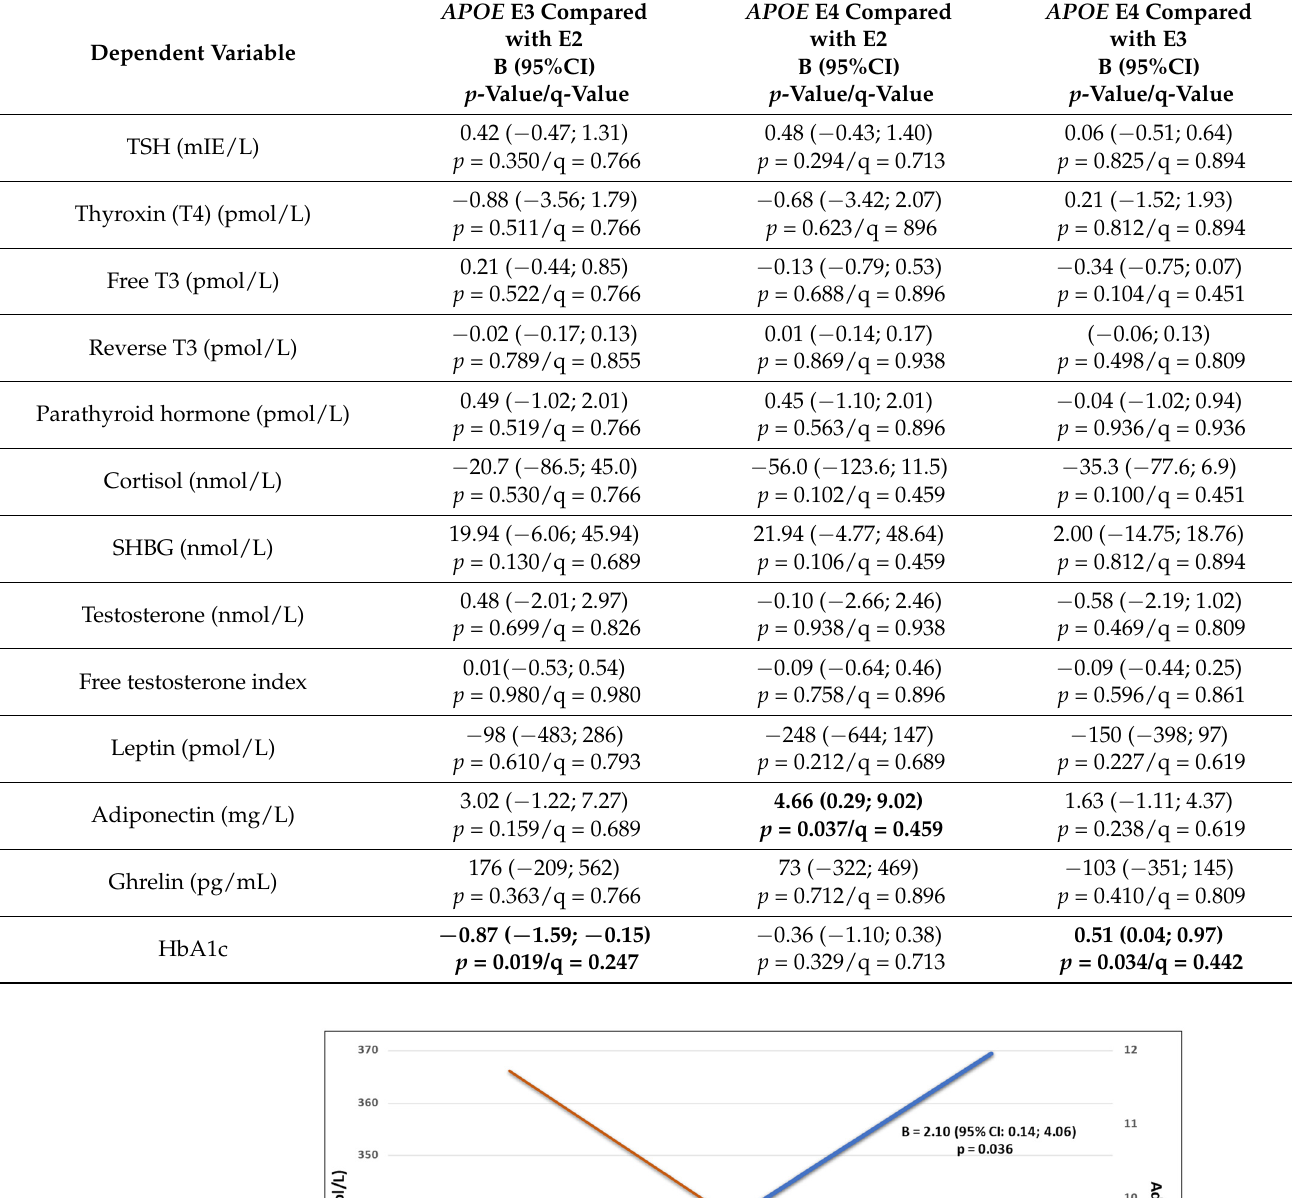
Table 3. Ordered APOE groups (E2-E3-E4) as a predictor of the hormones adjusted for age, gender, BMI and point of time (before/after surgery), analysed with linear mixed model. The q-values are Benjamini–Hochberg-adjusted p -values for 13 analyses between the APOE order and the hormones.